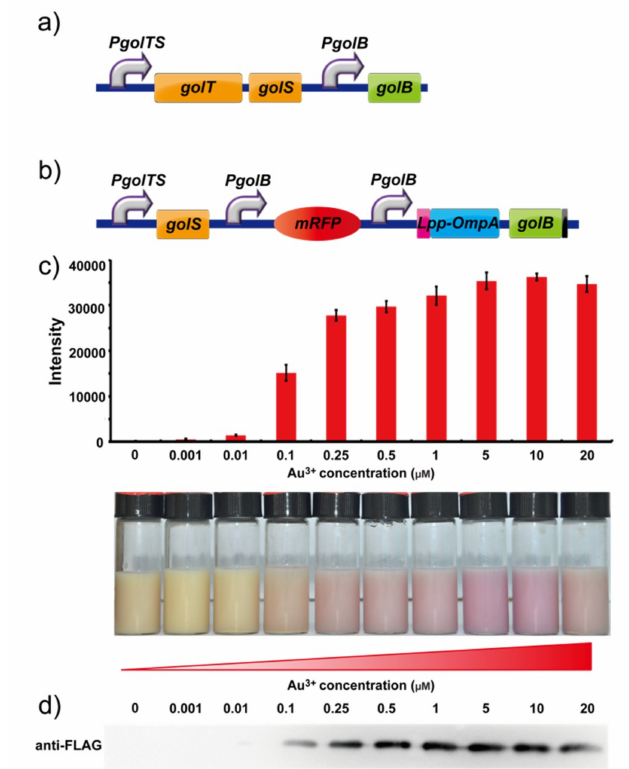
Figure 1. ( a ) Genetic organization of the gol locus in the S. typhimurium LT2 genome. ( b ) Genetic organization of the gold inductive RFP expression plasmid in E. coli . ( c ) Fluorescence measurement of E. coli cells containing the gold-induced RFP expression plasmid after induction with gradient concentrations of HAuCl 4 and resuspension in PBS buffer (pH 7.4) and a photograph of the corresponding fluorescence measurement. ( d ) Western blot analysis of the RFP expression under the different concentrations of Au 3+